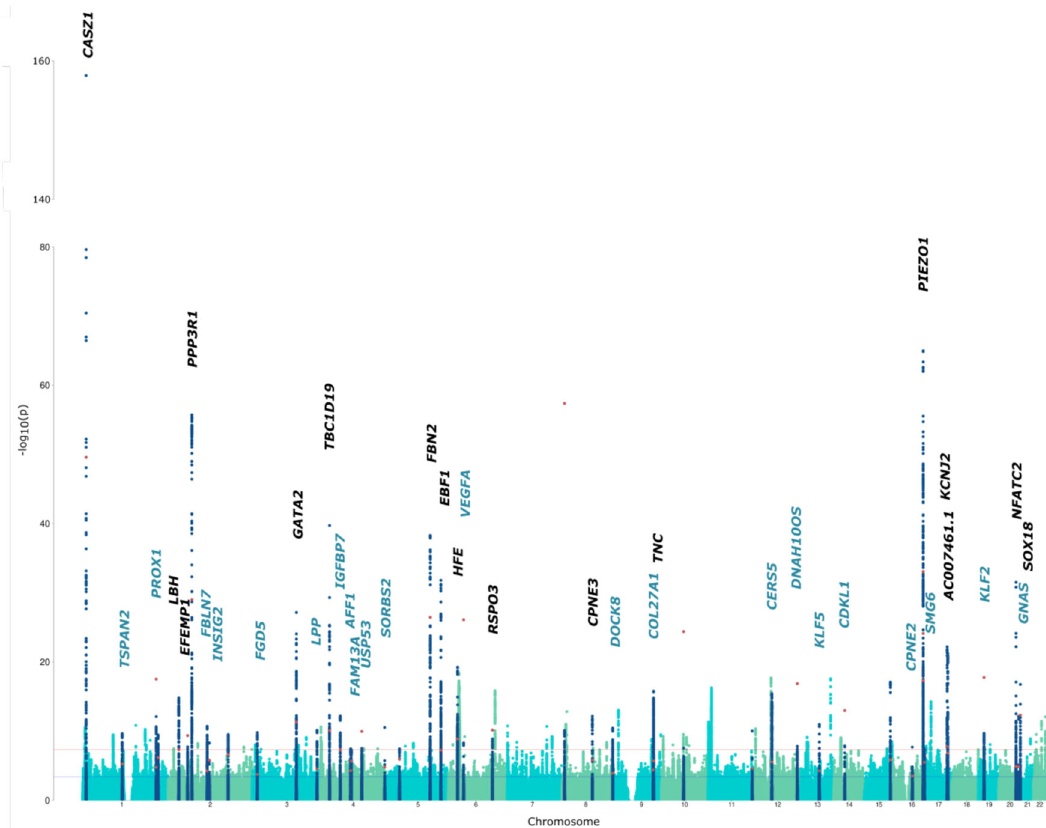
Fig. 2 Results of genome-wide association study in varicose veins. Manhattan plot showing genome-wide P -values plotted against position on each of the autosomes. The dark blue, light blue and green dots refer to the discovery UK Biobank Cohort, with the red dots corresponding to the 49 variants from the 23andMe cohort at each replicated locus (shown in Supplementary Data 2). The dark blue peaks correspond to the 46 loci that replicated in the 23andMe cohort at a Bonferroni-corrected threshold of P < 4.72 × 10 − 4 . Candidate genes at each locus are named above each signal, with previously unreported genetic loci in blue, and previously described loci in black.